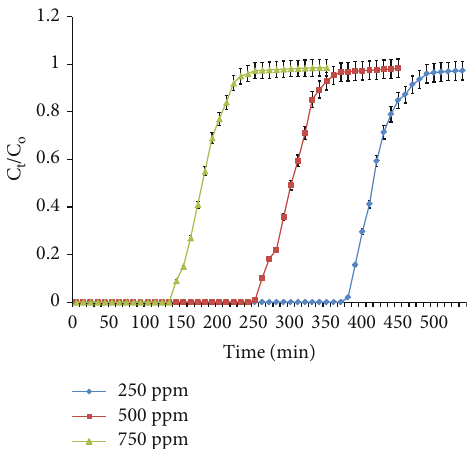
Figure 4: E ff ect of initial metal ion concentration on breakthrough curves obtained for the removal of Pb 2+ by ZSM-5/AC (bed height 6cm, fl ow rate 2mL min -1 , pH 6, 303 ° C, and error bars represent the standard deviation at n = 3 ).